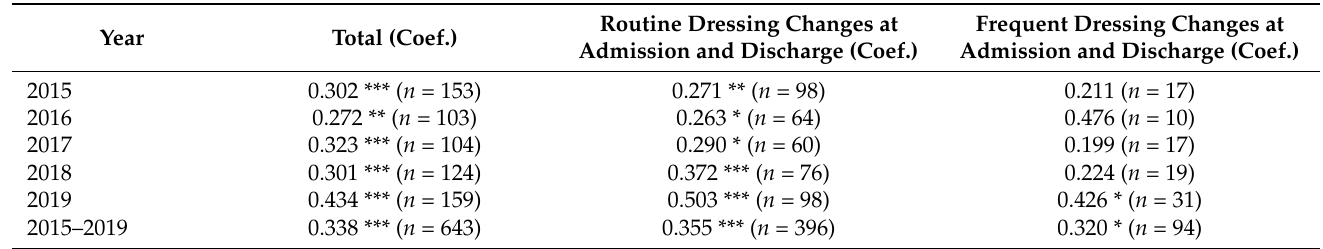
Table 2. Correlation analysis between TISS-28 (first) and TISS-28 (last) by year and by type of wound dressing changes.